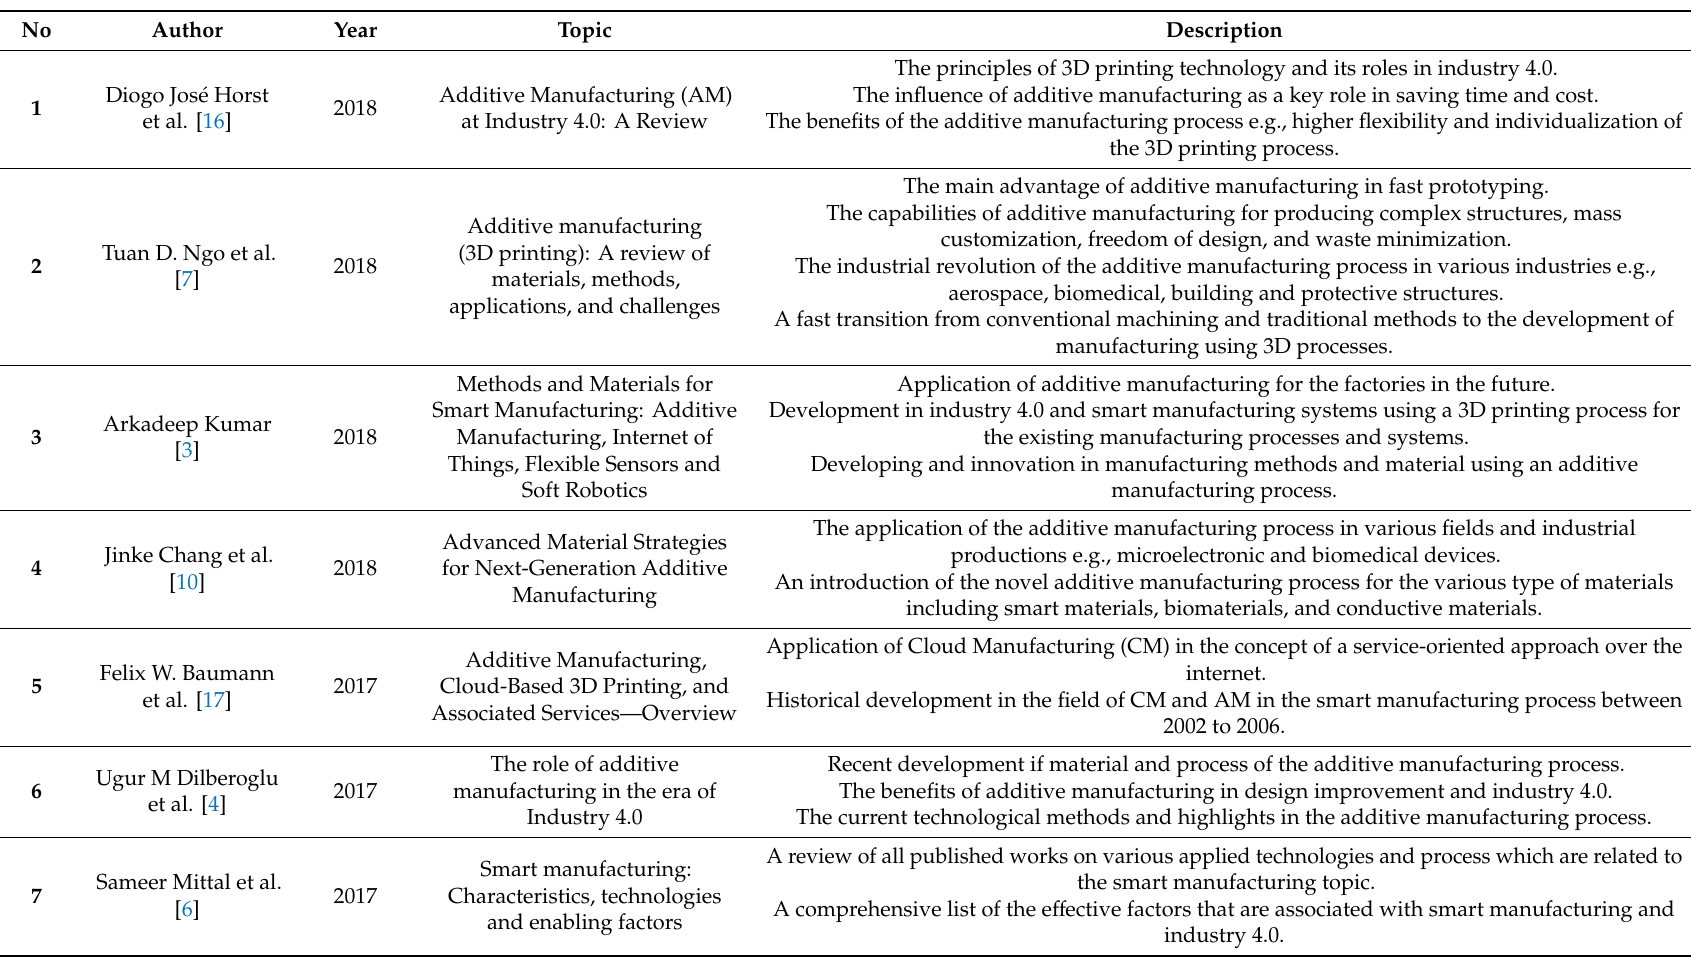
Table 1. Summary of published works on this